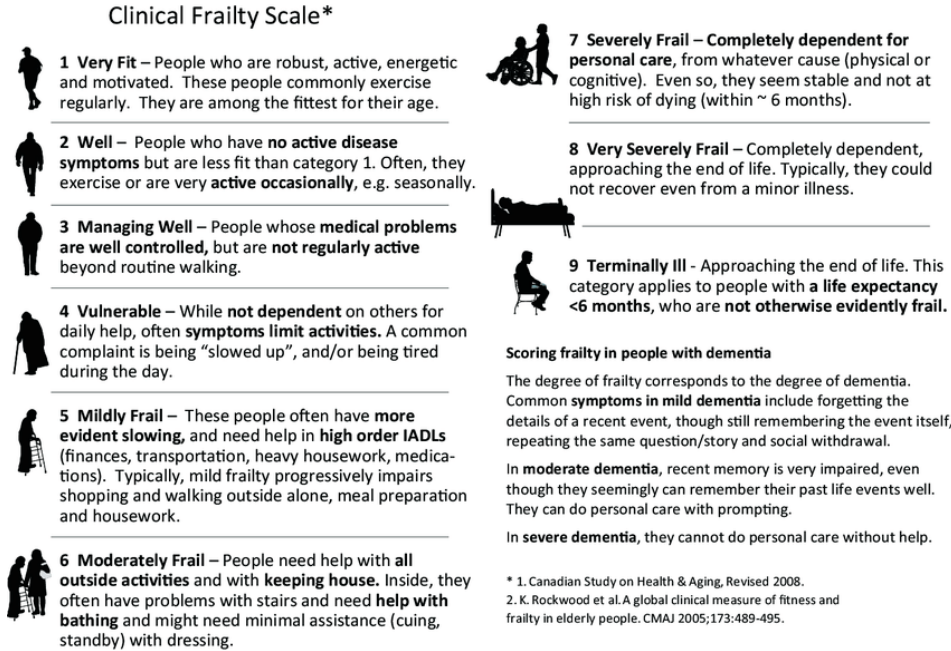
Figure A2. Clinical Frailty Scale adapted from Rockwood et al. [81]. Table A5. Liver frailty index [84].